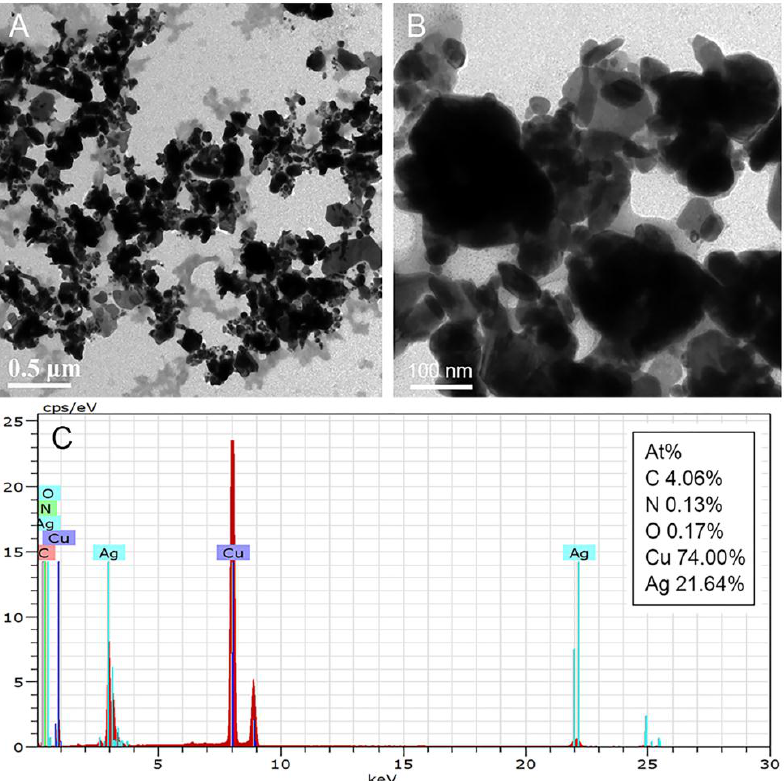
Figure 1. Characterization of the nanostructures. ( A , B ) Transmission electron microscopy (TEM) images of melanin–Ag nanocomposites at different magnifications. ( C ) Energy-dispersive X-ray spectroscopy (EDX) pattern of the nanostructures.